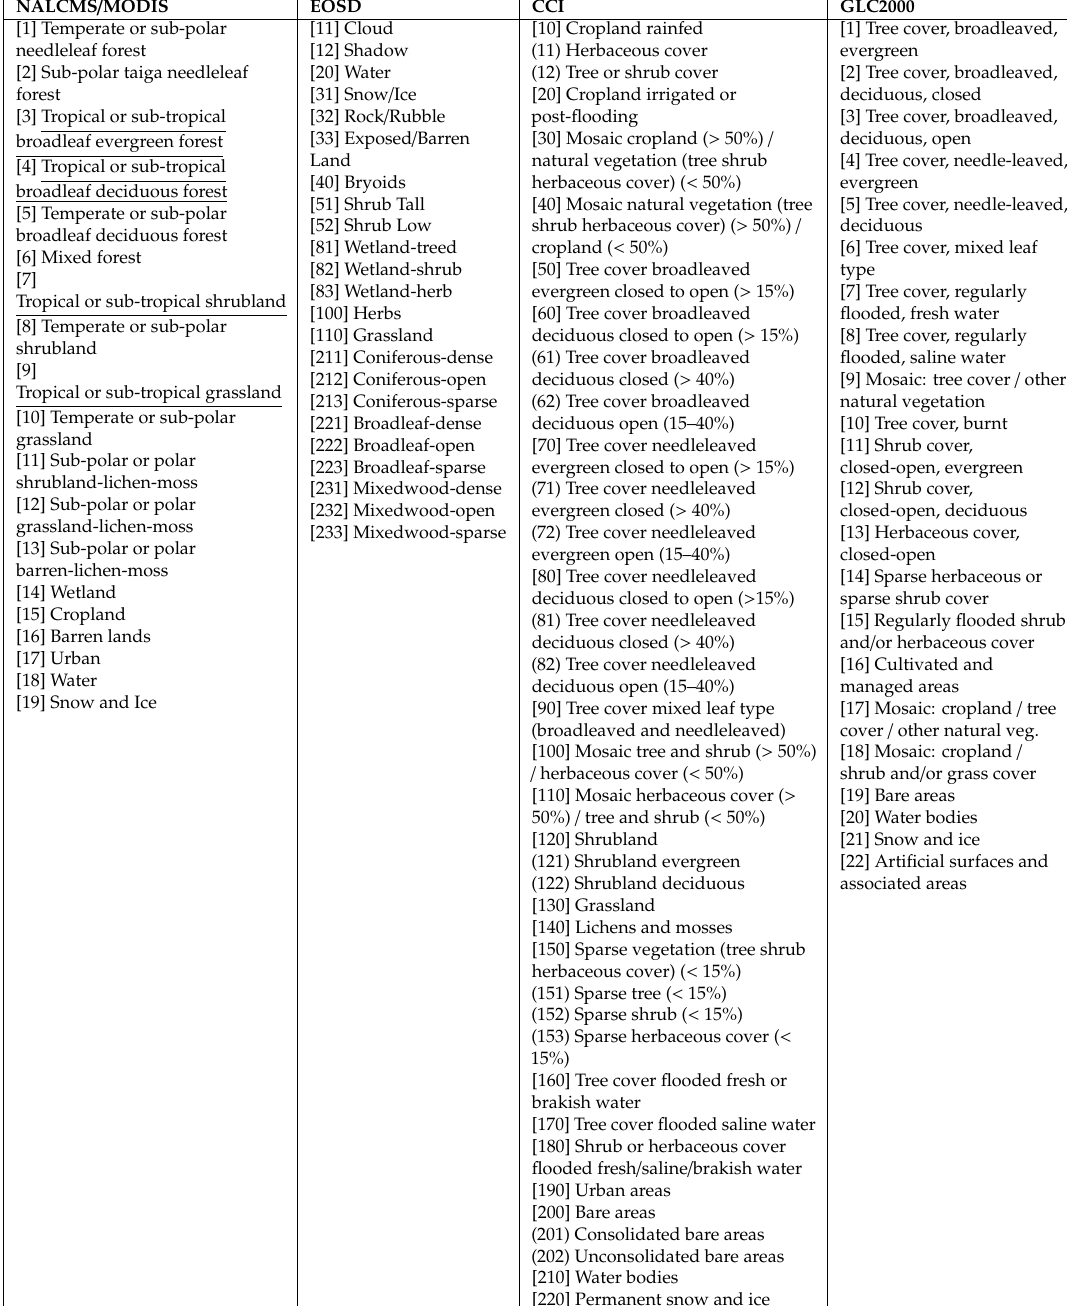
Table 1. Legends for land cover datasets included in this study. The parentheses in the CCI legend are used to indicate sub-classes, while the brackets show the main